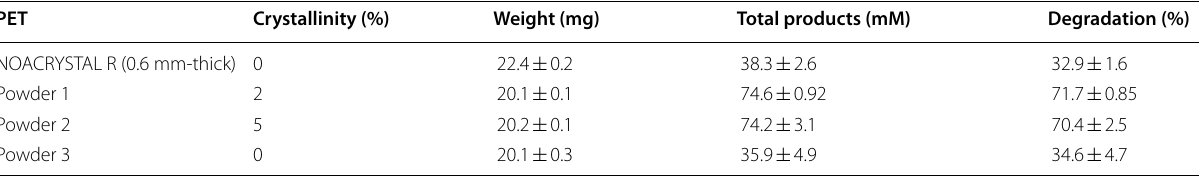
The reactions were performed at 63 °C for 3 days, as described in “Materials and methods”, using Cut190*SS and film (two chips/ml) and powder forms (approximately 20 mg/ml)